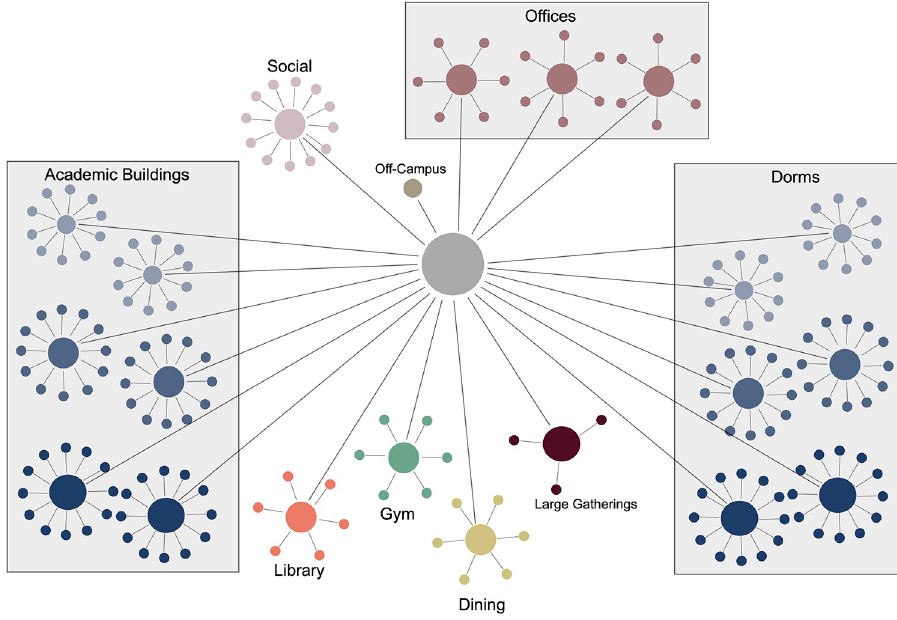
Fig 4. Schematic of the